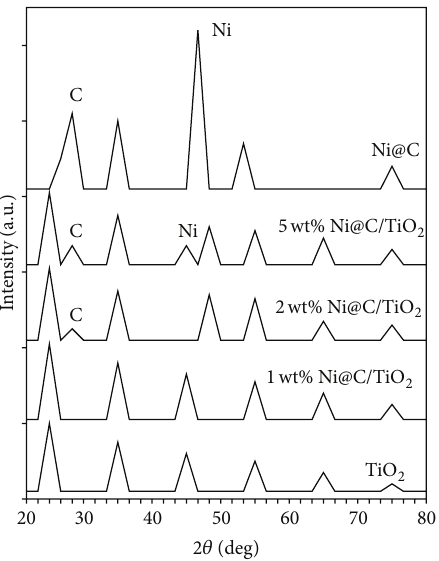
Figure 2: The measured XRD patterns of prepared C/TiO 2 /Ni nanocomposites with mass ratios of 1%/2%/5%; 5%/1%/2%, and 2%/5%/1%,